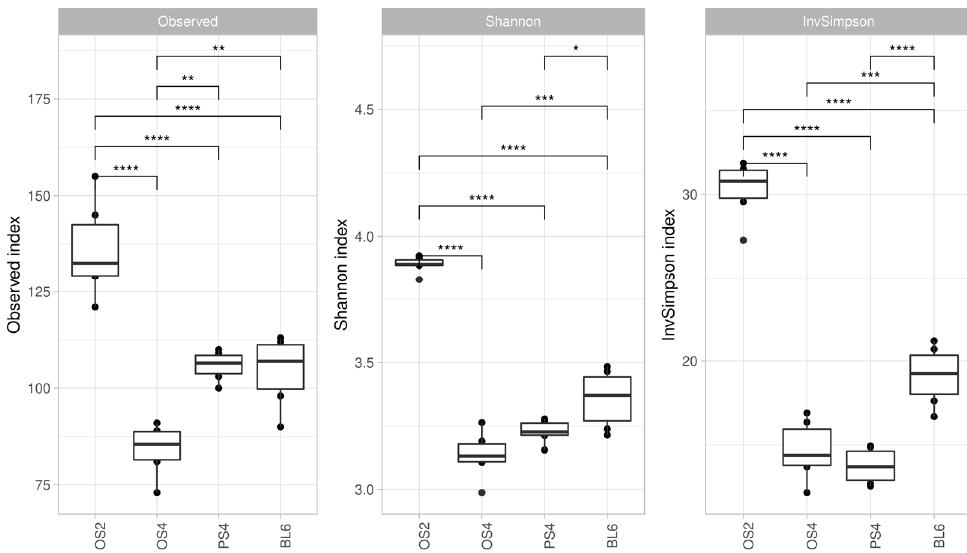
Figure 2. Alpha-diversity of four consortia (OS2, OS4, SD4, BL6) accessed by 3 indices—Observed, Shannon, InvSimpson, based on 16S rRNA gene libraries. Significant differences assessed by the Mann–Whitney test: (*) p -value ≤ 0.05; (**) p -value ≤ 0.01; (***) p -value ≤ 0.001; (****) p -value ≤ 0.0001. According to the beta-diversity metrics of 16s rRNA sequencing data, all four consortia were significantly separated from each other (R 2 = 0.7, p -value < 0.001) (Figure 3), even OS2 and OS4 from the same substrate (R 2 = 0.85, p -value = 0.0018). However, distances between consortia from oat straw were shorter than between others from different substrates. Bray–Curtis, UniFrac, and Weighted UniFrac metric systems showed the same trend but revealed differences in varying degrees (Figure S3).